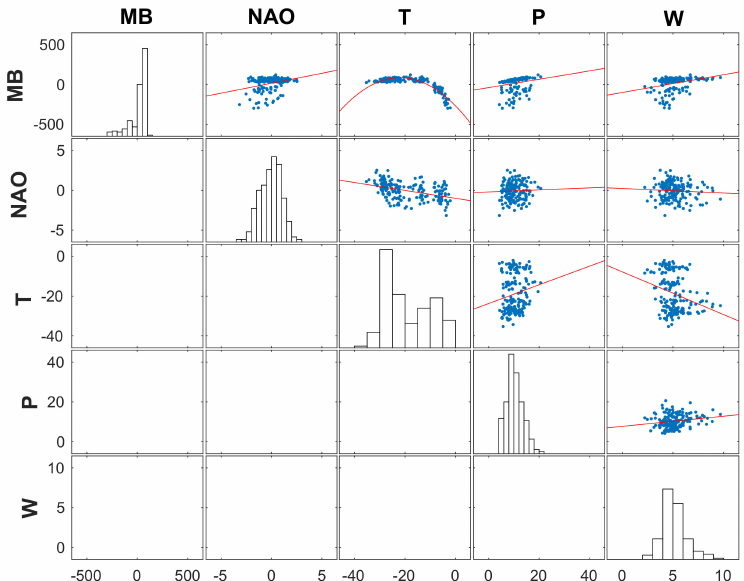
Figure 5. Scatterplots between mass changes (MB) and the investigated climate factors; North Atlantic Oscillation (NAO), T (temperature), P (precipitation), and W (wind). The correlation between the summer mass loss and mass balance (Table 1) is up to 0.88 ( p < 0.01). This indicates that a mass loss in Greenland is mainly attributed to summer melting of the ice